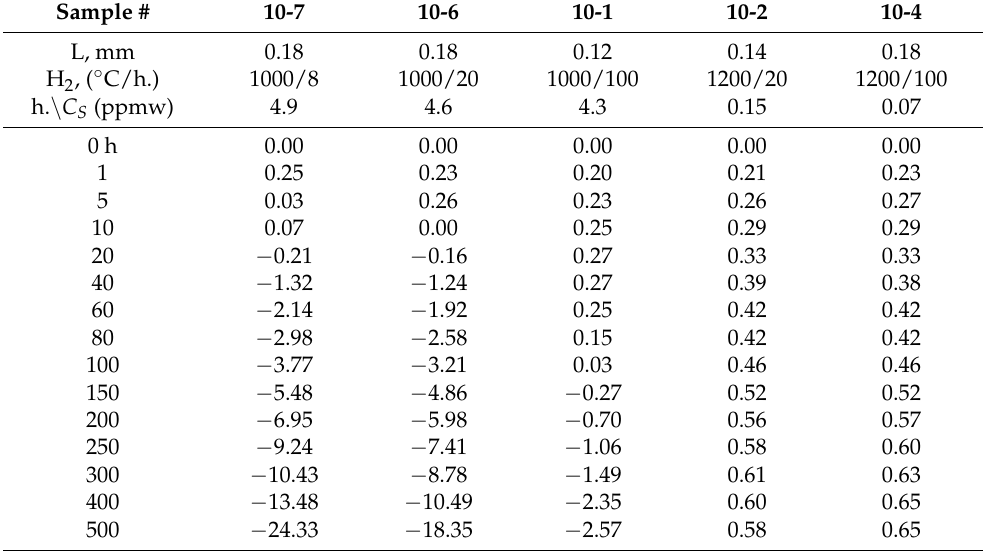
Table 1. Cyclic-oxidation specific weight change data for “10 mil” PWA 1480 samples (1100 ◦ C for 500 h in air). Effect of hydrogen annealing time and temperature. Measured sulfur content ( C S ) after hydrogen annealing; thickness (L) measured after polishing and before oxidation